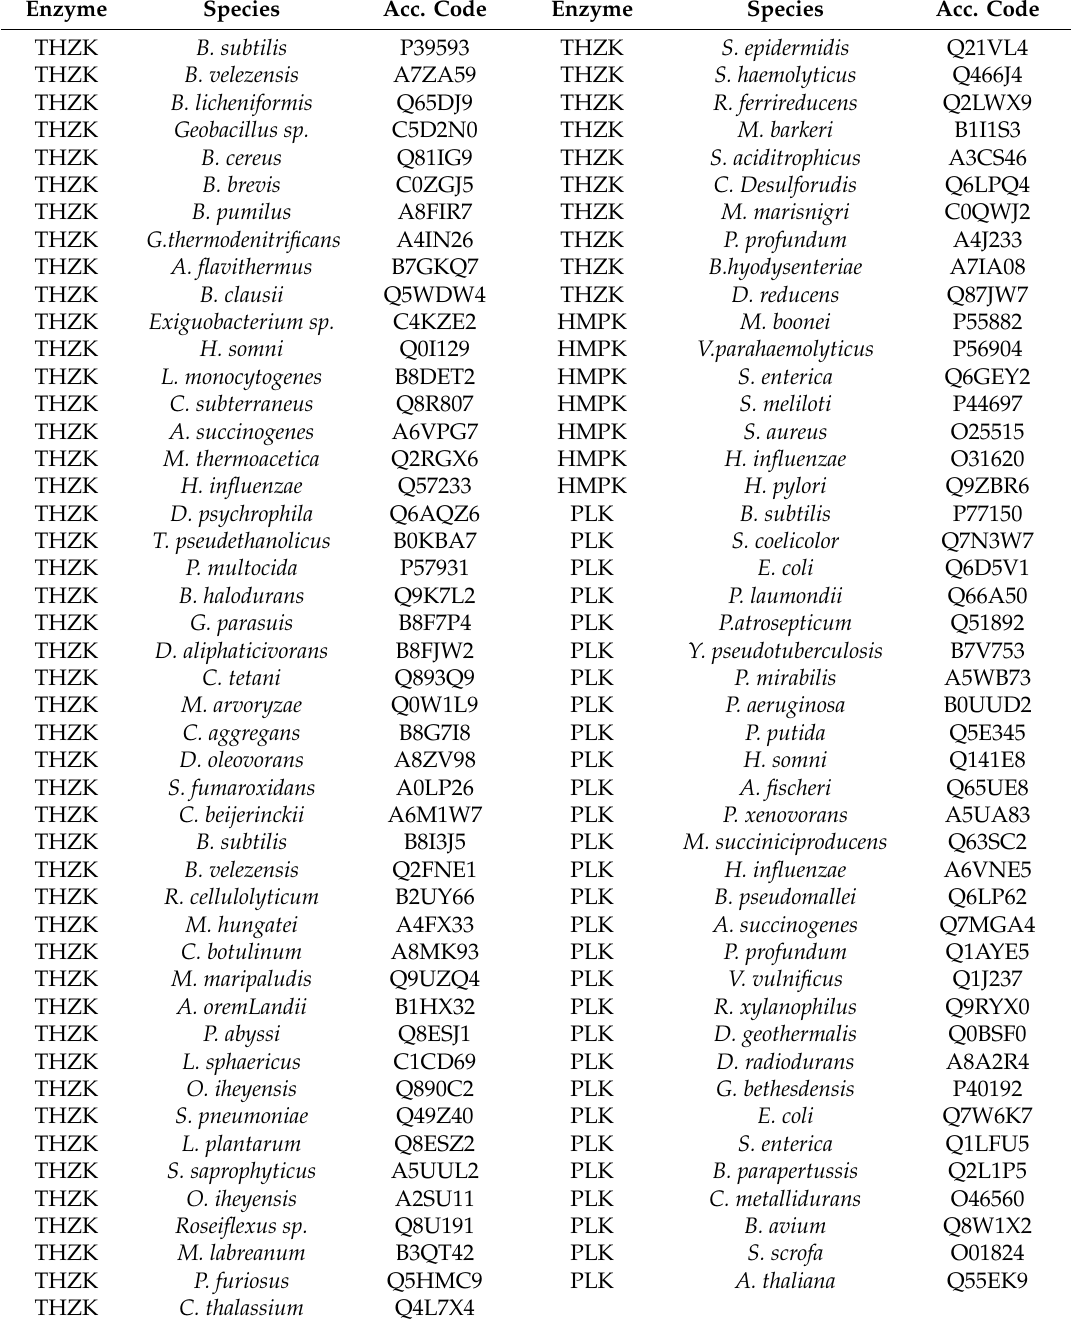
Table 2. Sequences employed for the rvET analysis of the ATP-dependent vitamin kinase family. Enzyme Species Acc. Code Enzyme Species Acc.